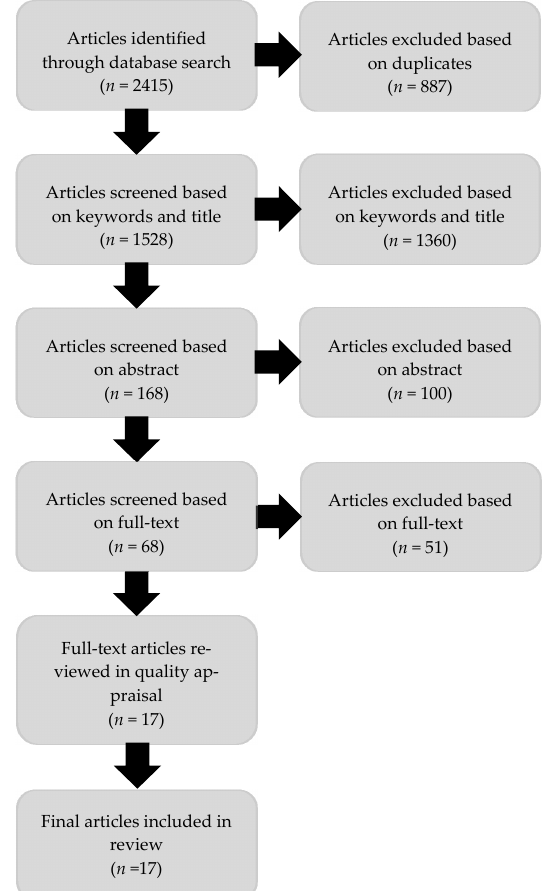
Figure 1. Flow diagram of review process.